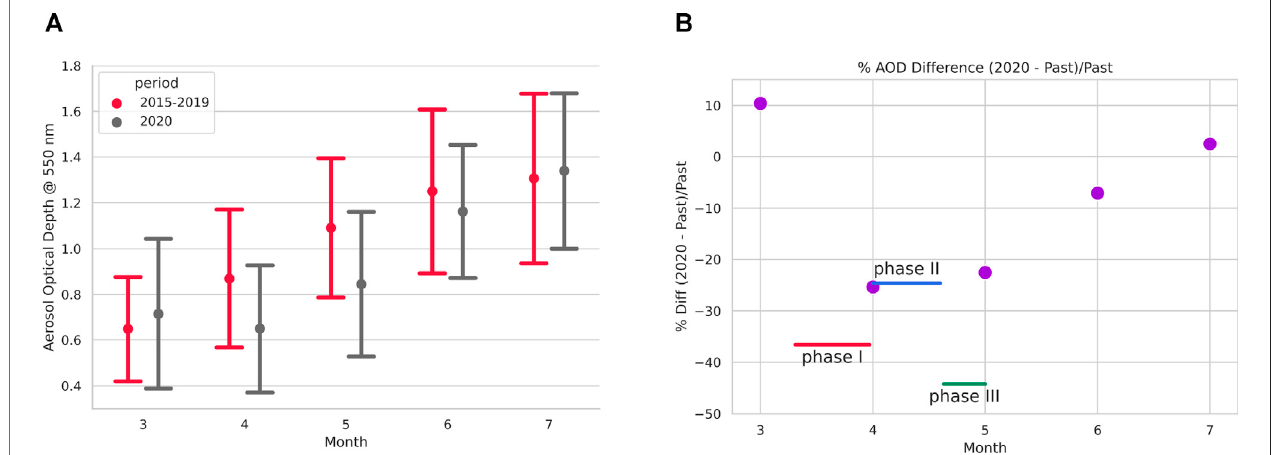
FIGURE5 | (A) VIIRS observationsof AOD over Delhi during months corresponding toCOVID-19lockdown and unlock phases during 2020 and comparison with the average of 2015 – 2019. (B) Percentage changes in AOD; the points show monthly % changes from the present study while the lines show data from Ranjan et al. (2020), with x-span of the line representing the period for which the change is